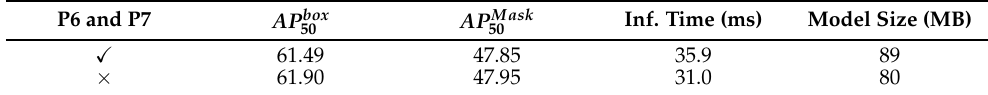
Table 3. Ablation study of P6 and P7 layer in the FPN.